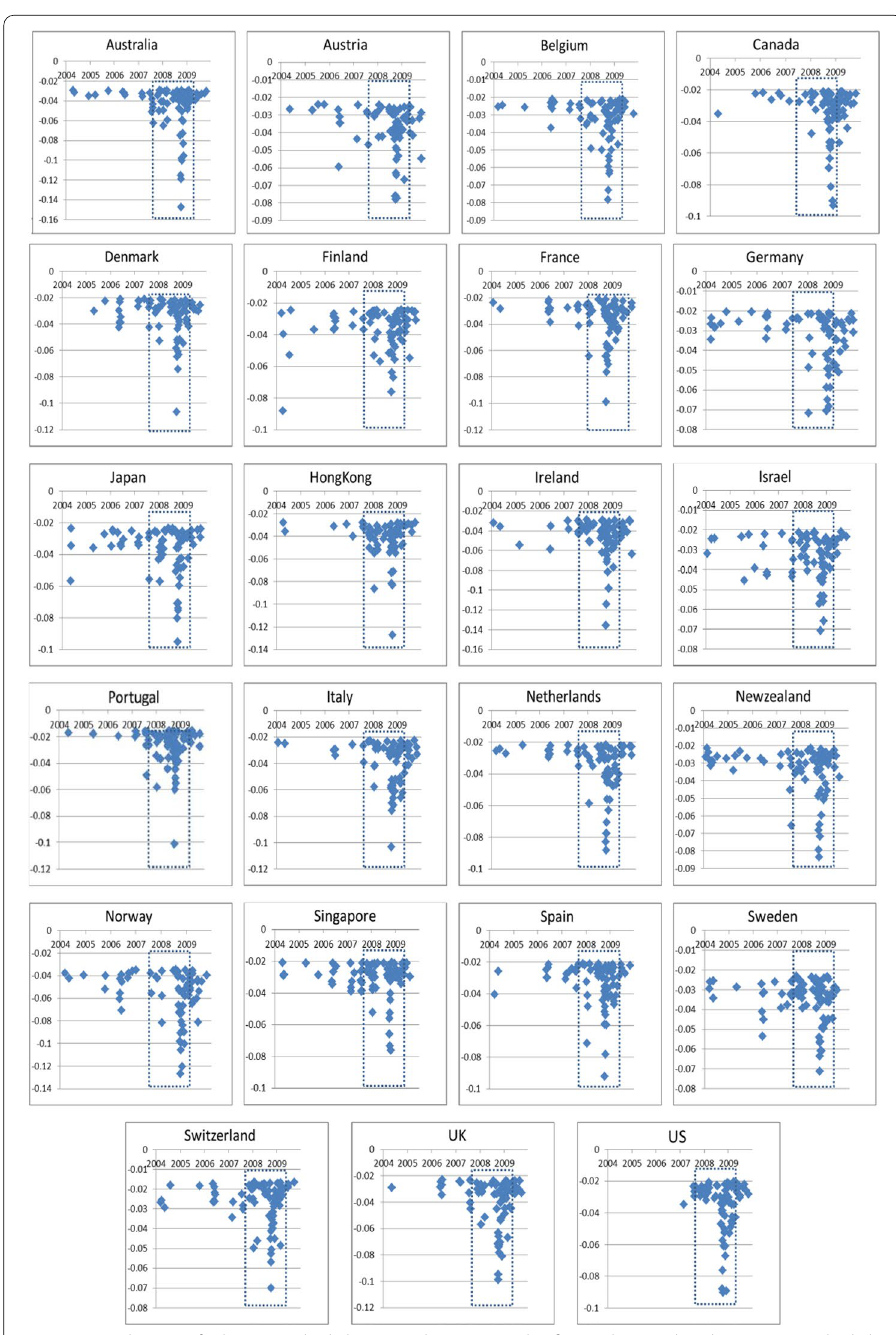
Fig. 10 Distribution of 5th percentile daily returns by country. This figure shows 5th or lower percentile daily returns by country against the sample period from January 2004 to October 2009. The crisis period from August 2007 to March 2009 is contained within the dotted line box